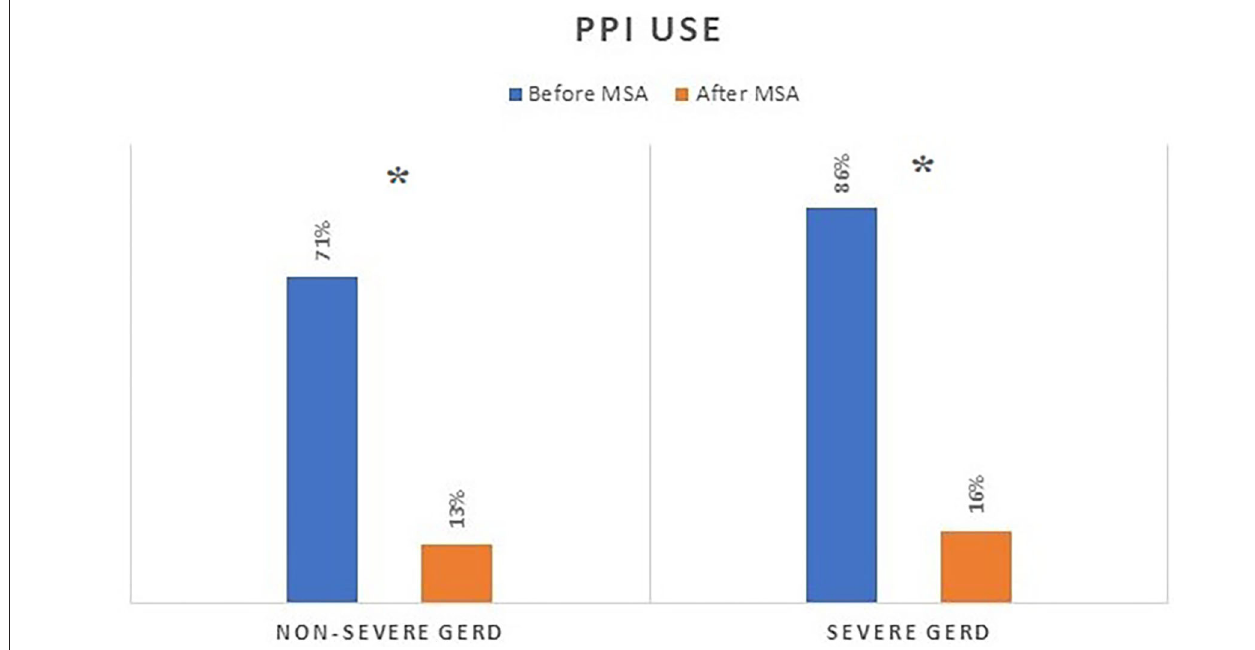
FIGURE 3 | PPI consumption before and after MSA procedure in patients with or without severe GERD. PPI, proton-pump inhibitors; MSA, magnetic sphincter augmentation; GERD, gastro-esophageal reflux disease; * p < 0.05.